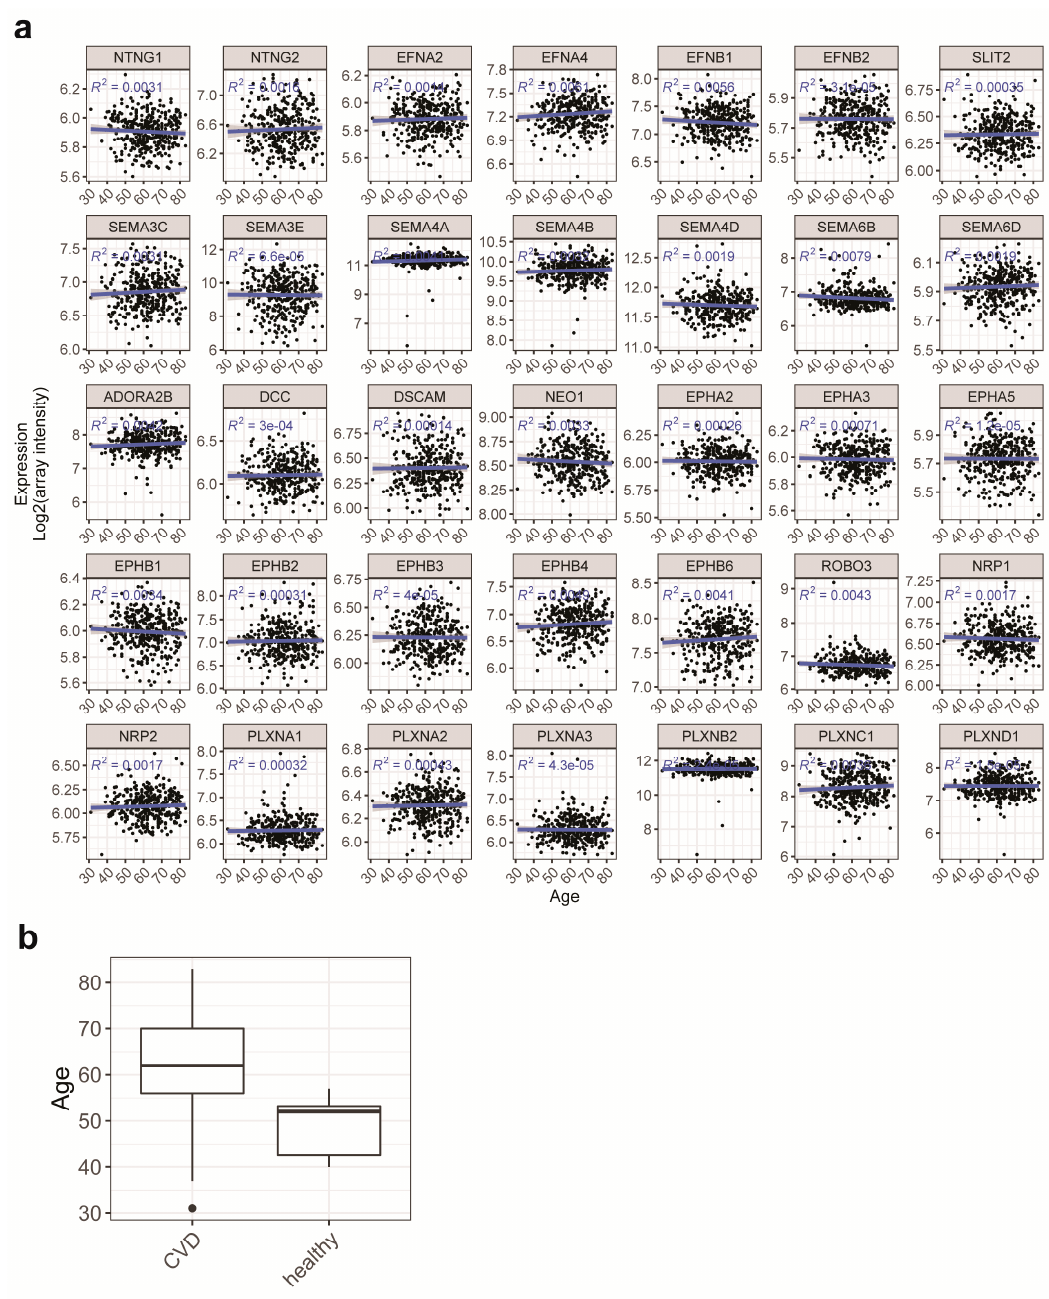
Figure 4. Influence of age as a potential confounding factor. ( a ) Scatter plots of expressions of selected NGCs in relation to age were made to show the influence of age on NGC expressions. Linear regressions were done with age being the dependent variable providing the fitted trend line (blue line), the 95% confidence interval of the trend (gray area) and the regression R-squared. Correlations of NGC expressions and age are minimal, as indicated by the R-squared values. ( b ) Boxplot of age distribution in CVD patients and healthy individuals. Young age dominates in the healthy individuals.